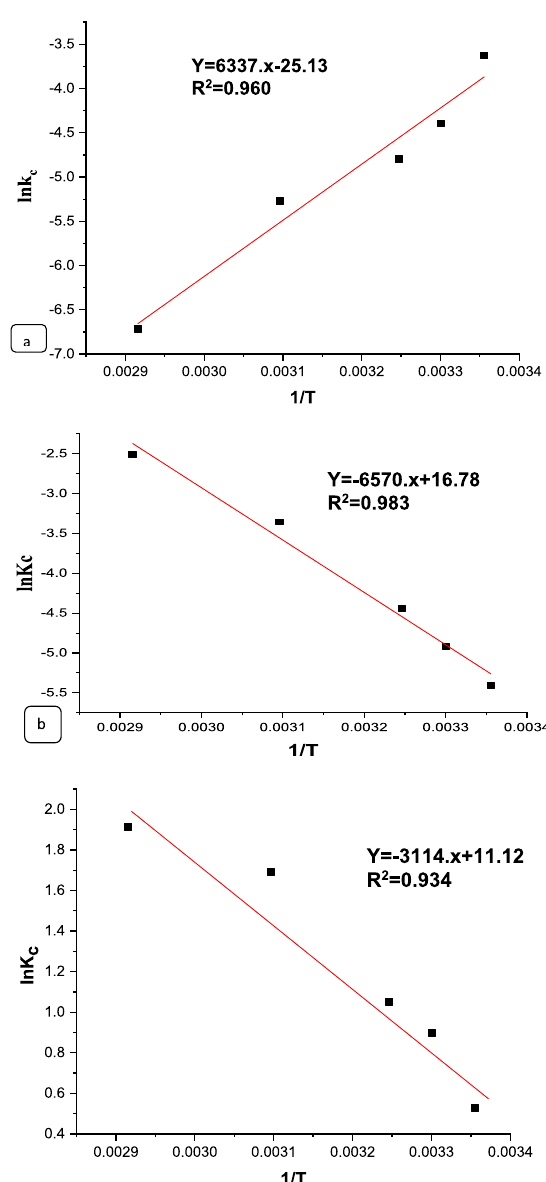
Fig. 15 Pseudo-second order for the adsorption of MG onto a nano-bentonite, b MgO impregnated clay and c raw bentonite